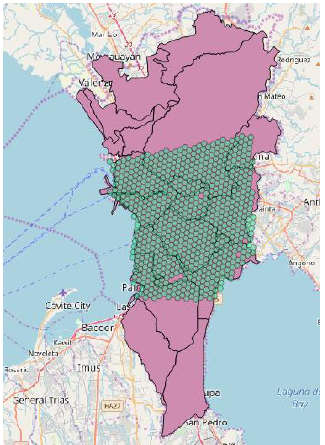
Figure 1. Uber Movement coverage (cyan hexagon) overlaid with Metro Manila